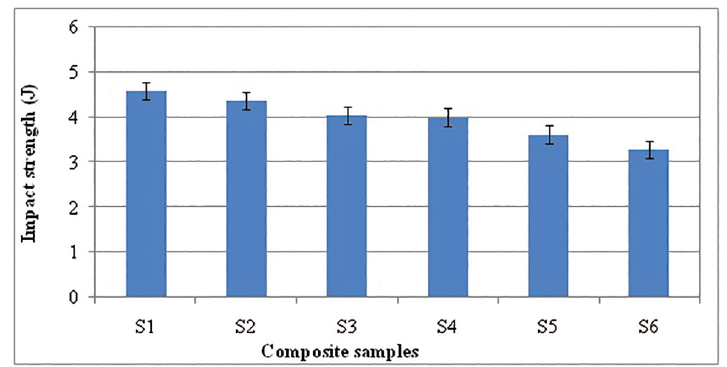
Figure 12: Impact strength comparison of carbon/banana fiber reinforced hybrid composites